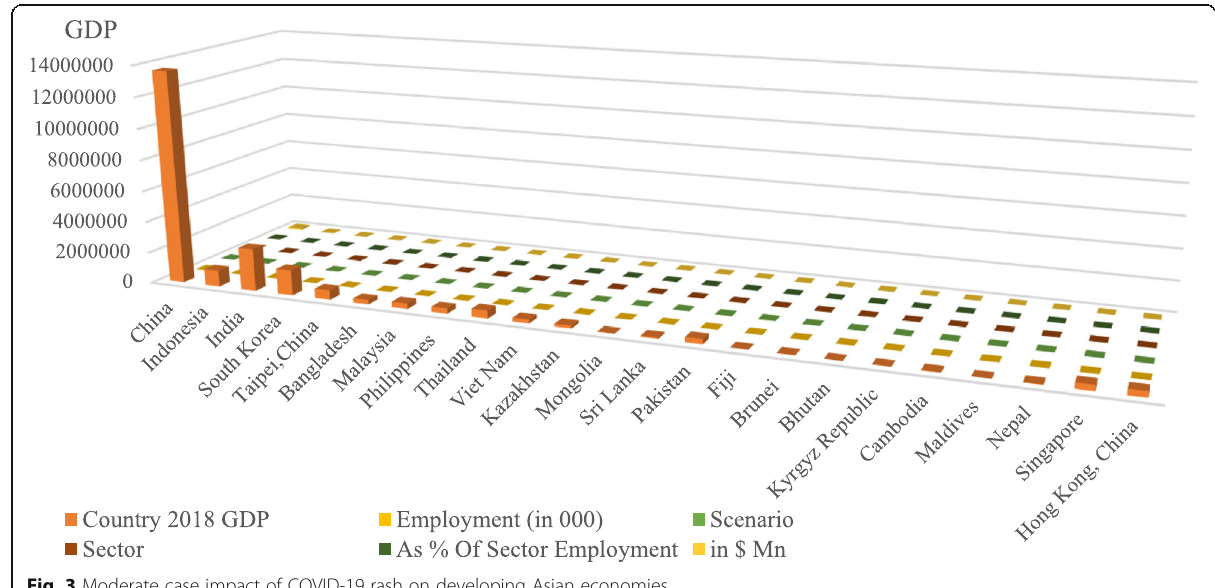
Fig. 3 Moderate case impact of COVID-19 rash on developing Asian economies